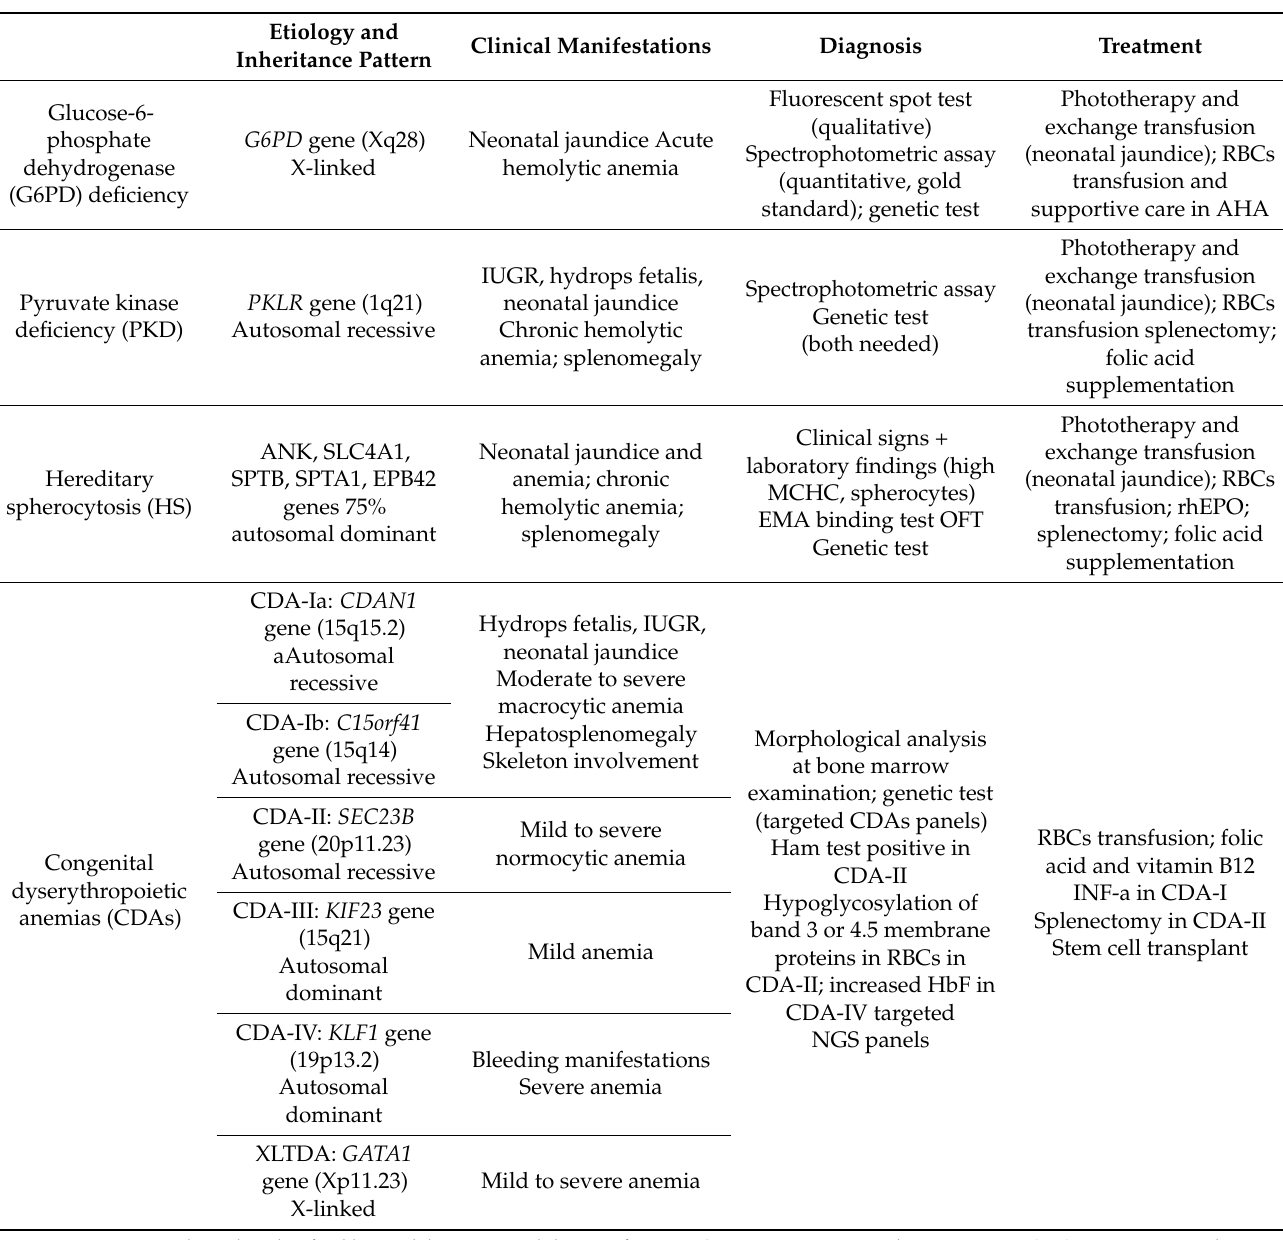
Table 4. Summary of the CHAs reviewed in this article: neonatal and pediatric